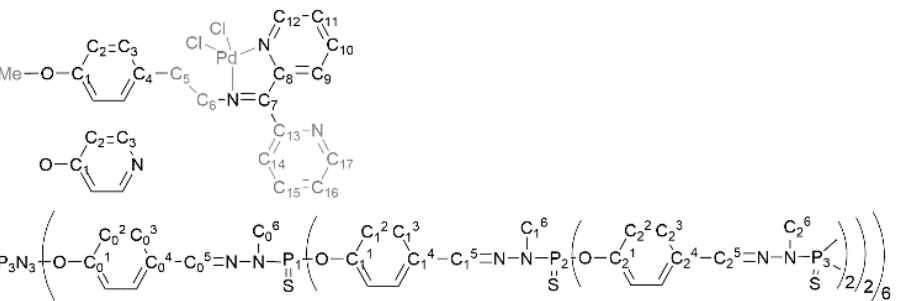
Figure 13. Numbering used for NMR assignment. The atoms in grey color are not present in some compounds.